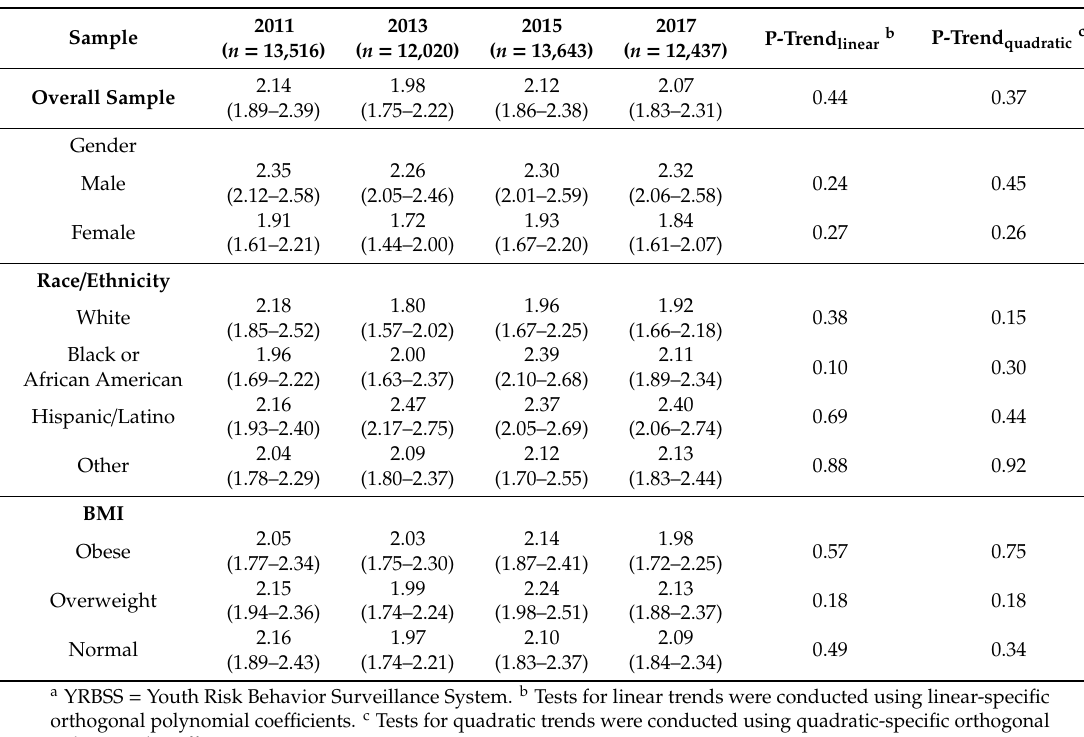
Table 2 indicates the weighted mean number of days per week in physical education class for the overall sample and population subgroups across the measured YRBSS cycles from 2011 to 2017, respectively. For the overall sample, there were no linear and quadratic trends (P linear = 0.44 and Table 2. Weighted mean number of days per week youth engaged in physical education classes (2011 – 2017 YRBSS; N = 51,616) a .